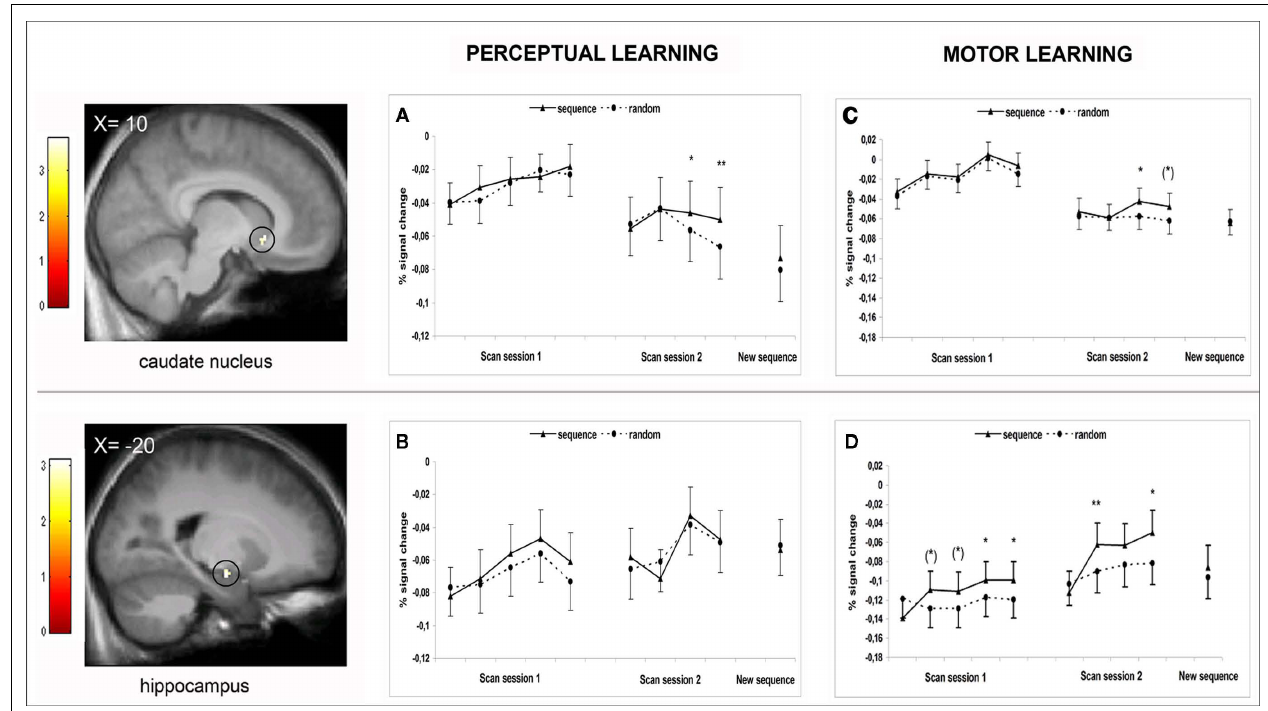
motor sequence learning (Gheysen et al., 2010); MNI coordinates: − 20, − 10, − 14; 8 voxels), mapped onto an anatomical mean image of all participants and defining the hippocampus ROI for further psc analyses. (B) psc data of the hippocampus ROI plotted over all blocks of first and second scanning session of the perceptual sequence learning study. (D) psc data of the hippocampus ROI plotted over all blocks of first and second scanning session of the motor sequence learning study. Color bars denote the t -value. Error bars represent 95% confidence intervals, (*) p < 0.06, * p < 0.05, ** p <